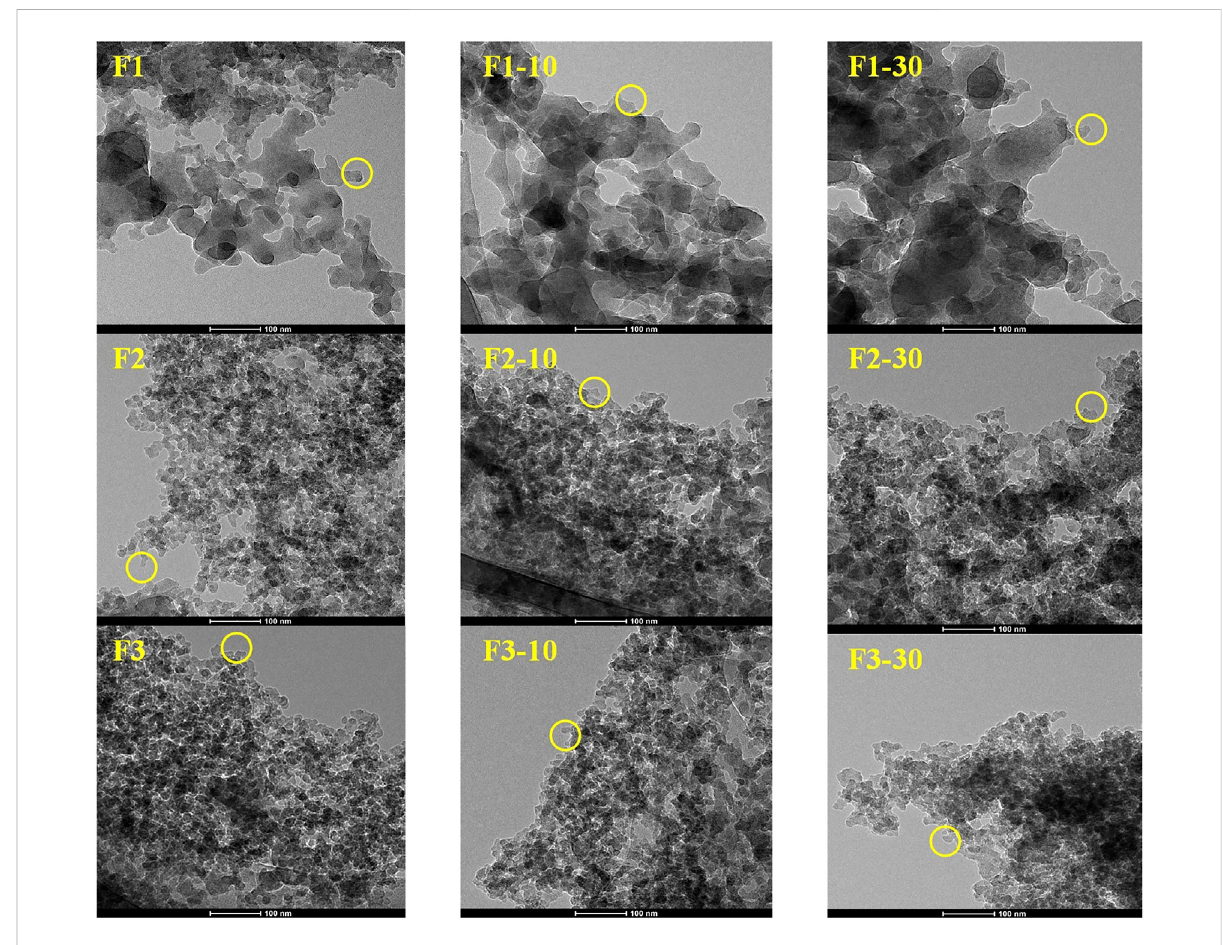
FIGURE 2 Typical TEM images of soot in fl ames with different magnetic fi